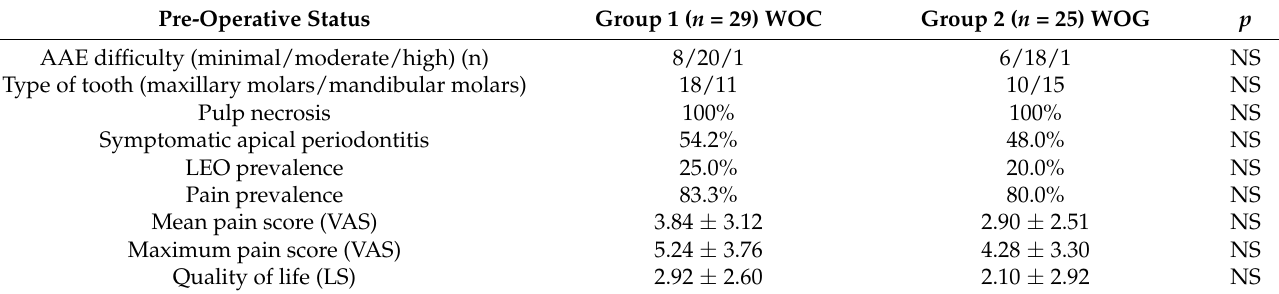
Figure 1. Observational study flowchart divided for each group. Table 2. Baseline patient demographics and characteristics.